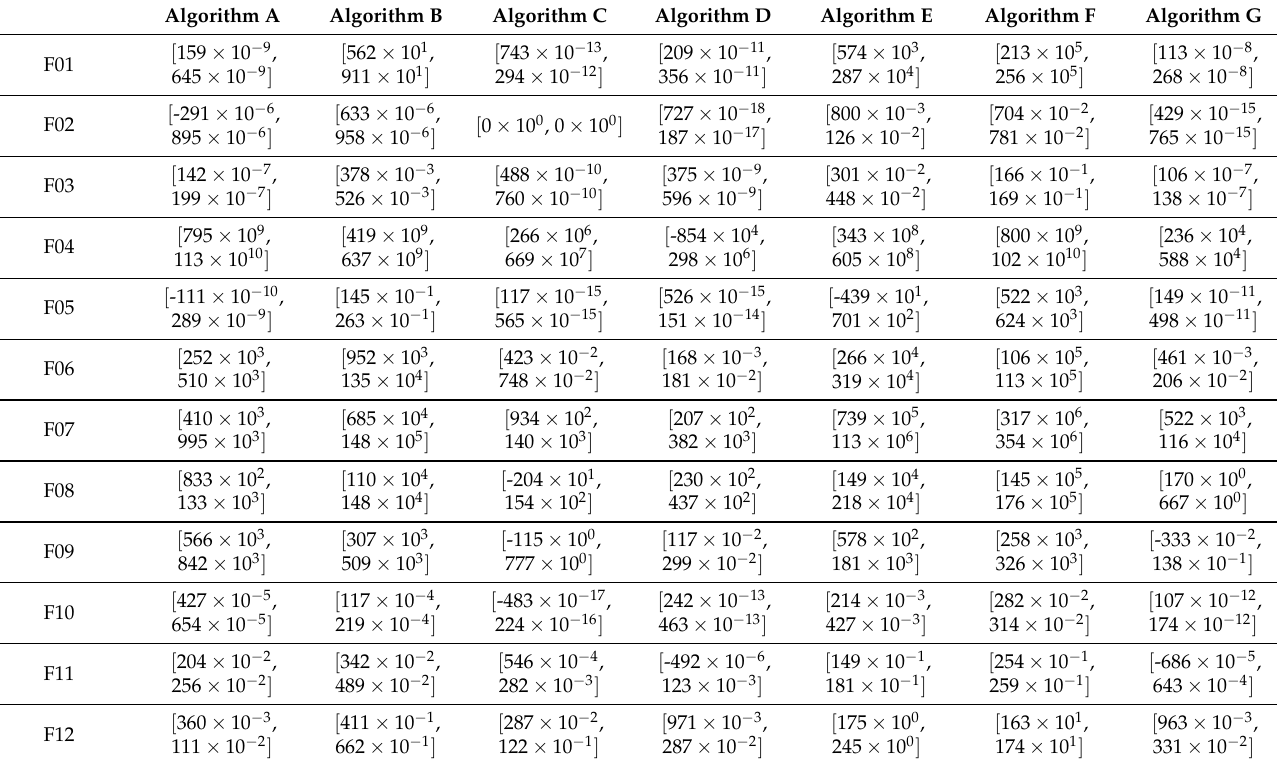
Table 12. Confidence intervals for sample mean of the solution